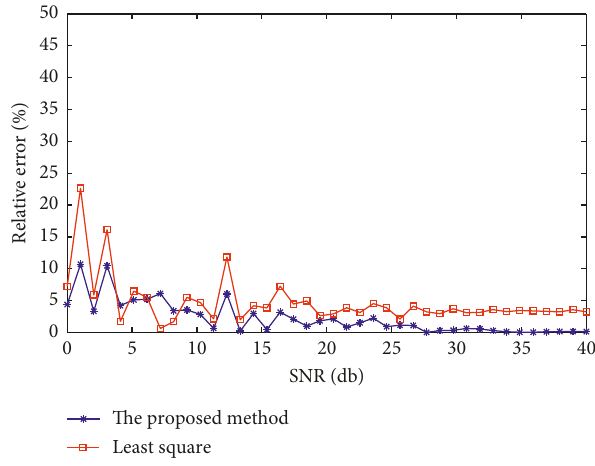
Figure 1: The relative error under different noise